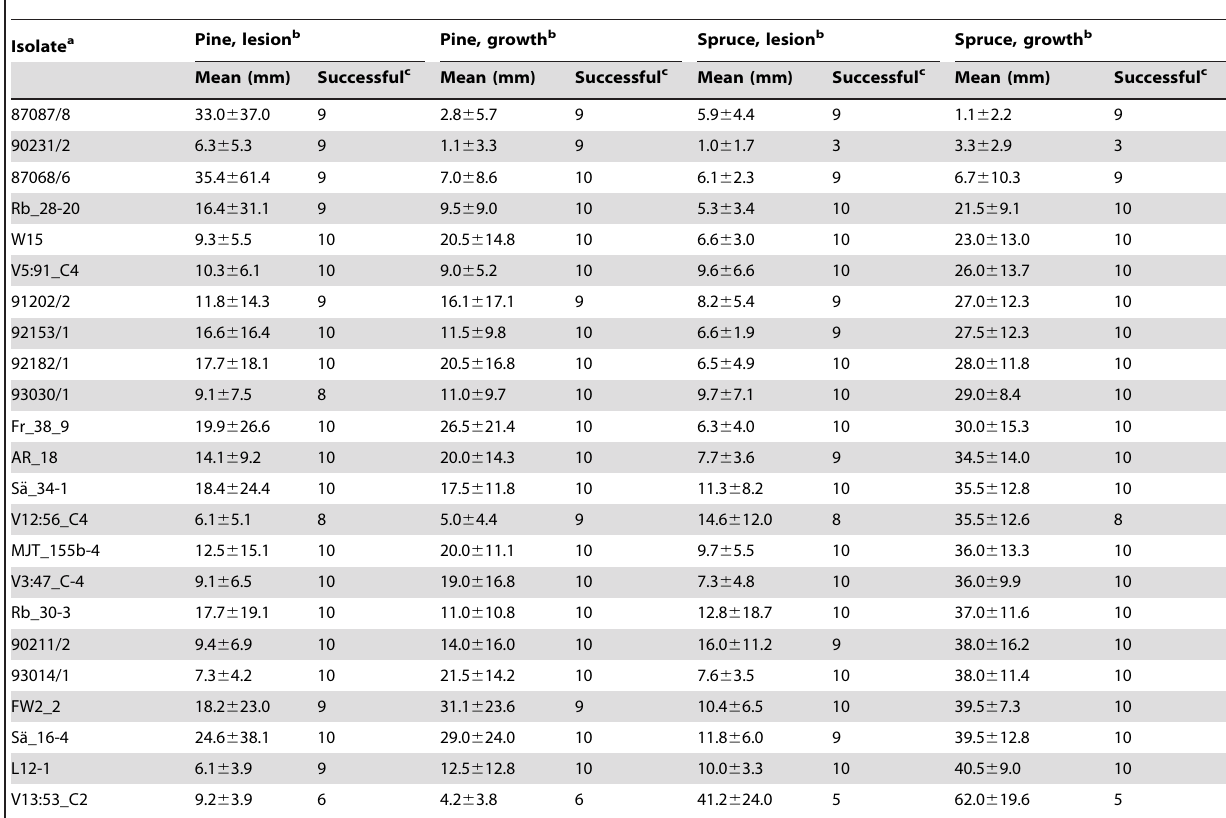
Table 2. Heterobasidion annosum s.s . virulence analysis on Picea abies and Pinus sylvestris .